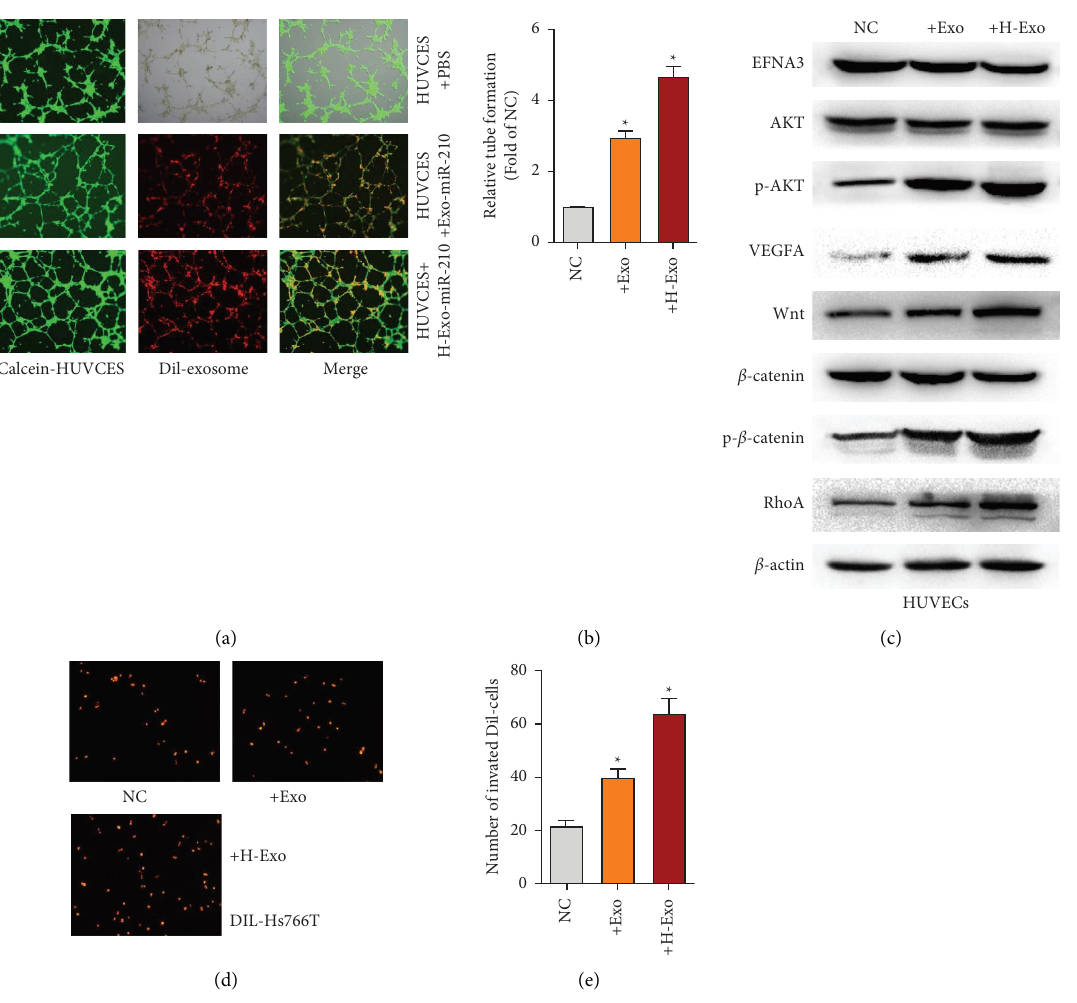
Figure 7: Exosomal miR-210 promotes tumor progression via EFNA3 PI3K/AKT/VEGFA or EFNA3/Wnt/ Β -catenin/RHOA (a) Te in vitro angiogenesis abilities of the indicated treated HUVECs were measured by tube formation assays. Magnifcation, × 200. (b) Relative expression of the indicated proteins in the indicated HUVECs was measured by WB analysis. (c) In the transwell assay, the tumor cells that passed through the endothelial monolayer were imaged by fuorescence microscopy. Magnifcation, ×